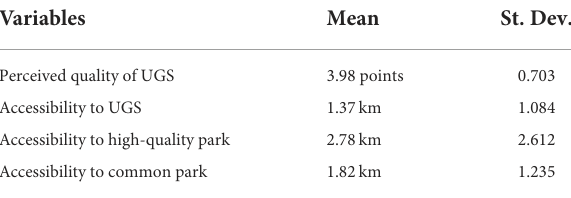
TABLE 3 Descriptive statistic of perceived quality and accessibility to